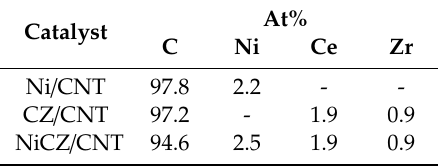
Table 4. The composition of prepared